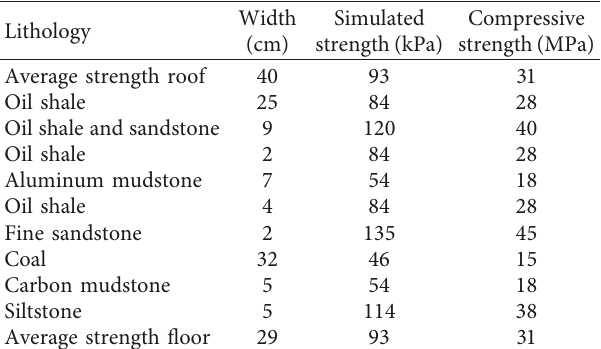
Table 2: Proportion of similar